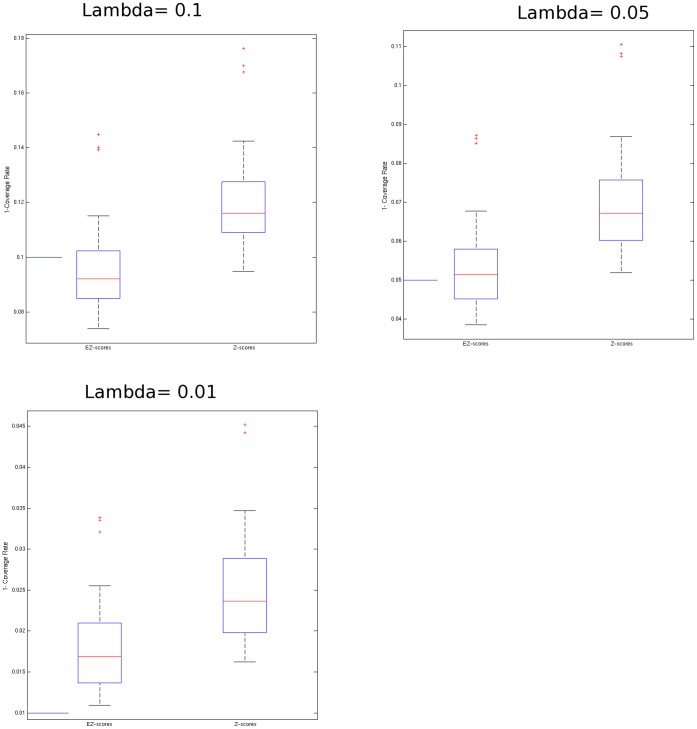
Box plots of uncoverage rates for normal control test subjects.Using 21 control subjects as the reference group, EZ-scores were derived for each normal control test subject (“Normal Subjects”, n = 21; different subjects than those comprising the reference group). The actual uncoverage rate, defined as the proportion of voxels lying outside of ± z1-λ/2 in each “Normal Subject”, was determined at three percentiles, corresponding to three theoretical uncoverage rates, (λ), 0.1, 0.05, 0.01. Box plots show the range of actual uncoverage rates across the 21 “Normal Subjects” for each of the three theoretical percentiles, each corresponding to the chosen λ. In each plot, closeness to λ, marked in blue, indicates better correspondence of the subject measurement to the expected distribution. Outliers in each box plot, marked with red+signs, are defined as values that are more than 1.5 times the interquartile range away from the top or bottom of the box. Observed uncoverage rates produced using EZ-score, as compared to the standard Z-score approach, indicate that EZ-score better represents the standard normal distribution and, therefore, provides a more accurate threshold for determination of abnormality with respect to a relatively small reference group of control subjects.